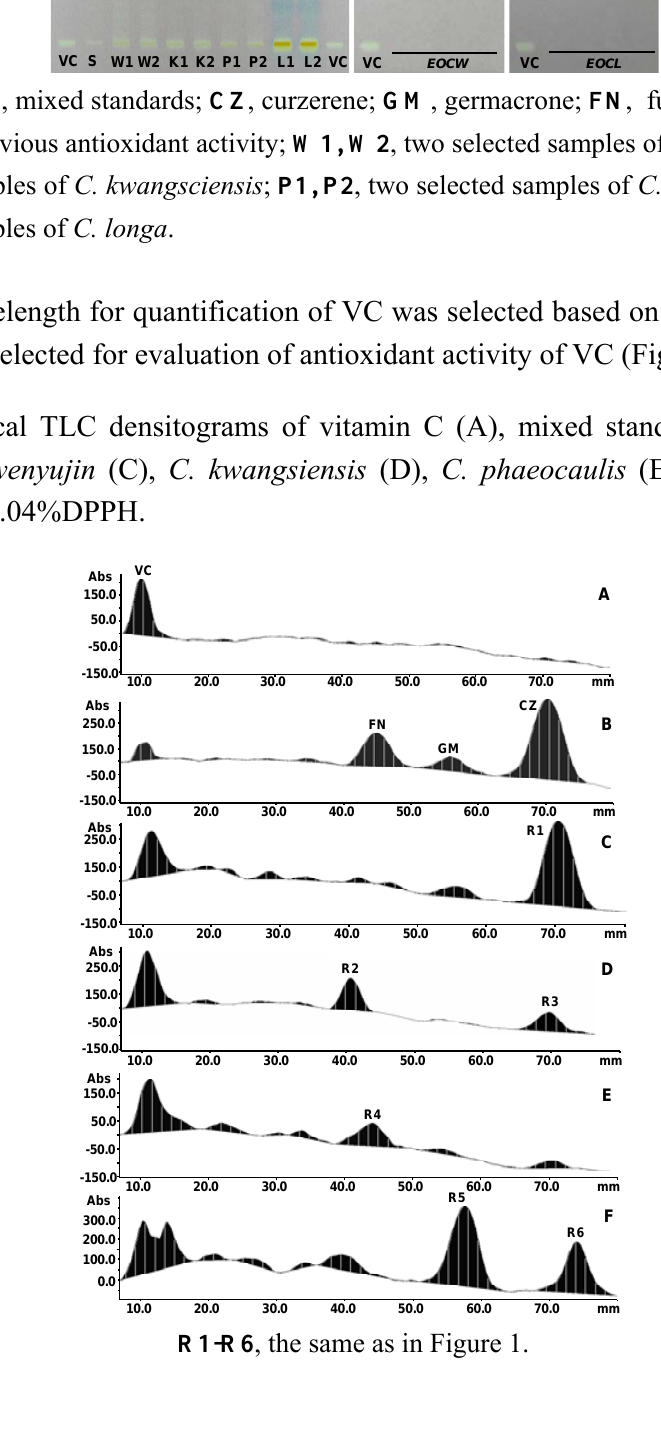
R1-R6 , the same as in Figure